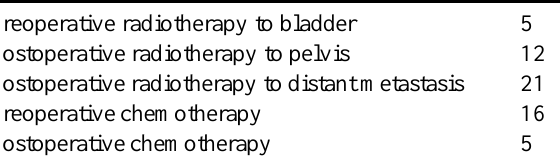
Table 2 – Number of patients with radiotherapy or